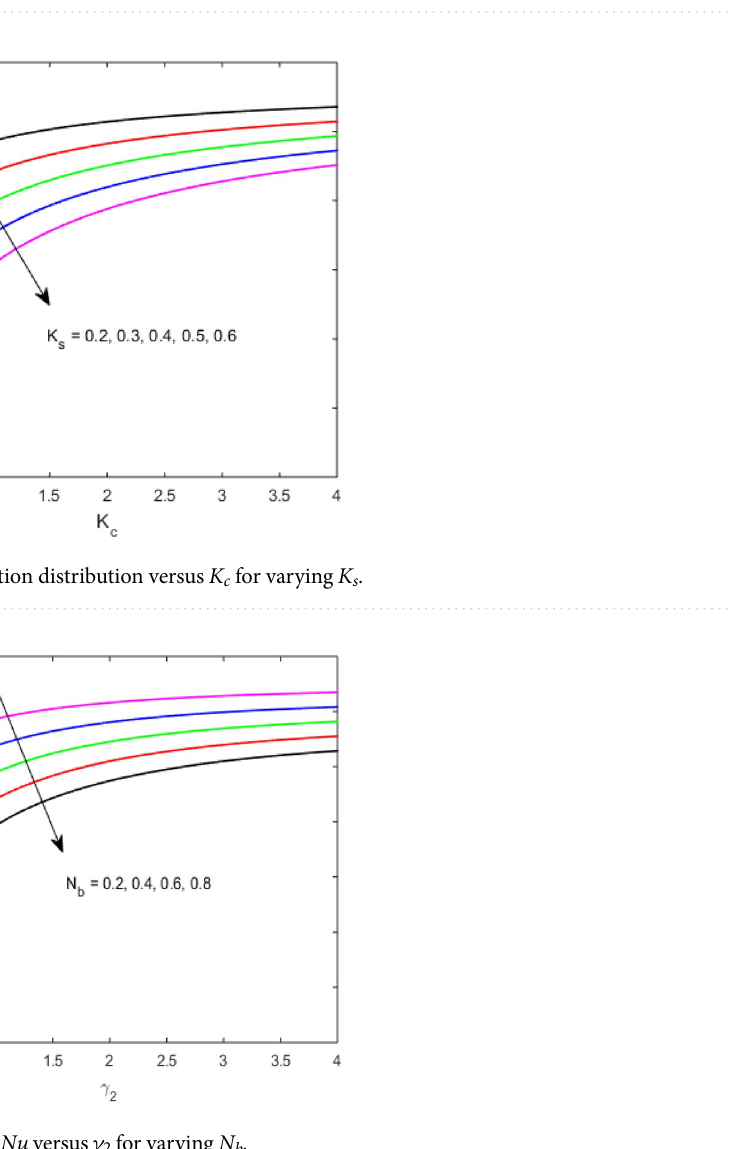
Figure 10. ( Re r ) − 1 / 2 Nu versus γ 2 for varying N b